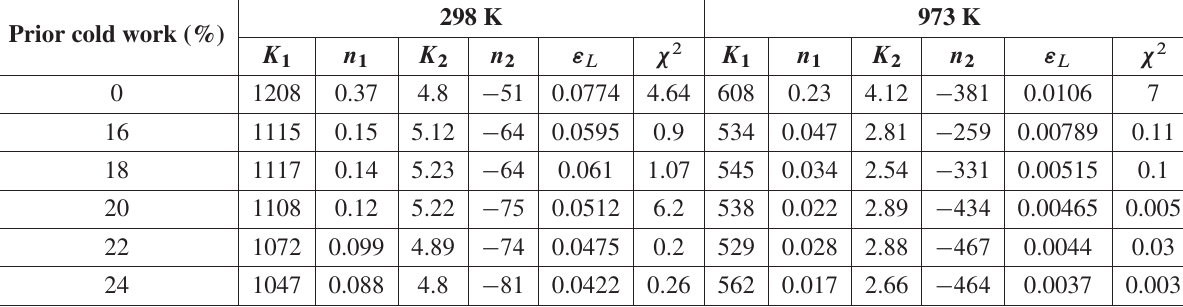
Table 1. Parameters derived from Ludwigson equation for test temperatures of 298 K and 973 K.